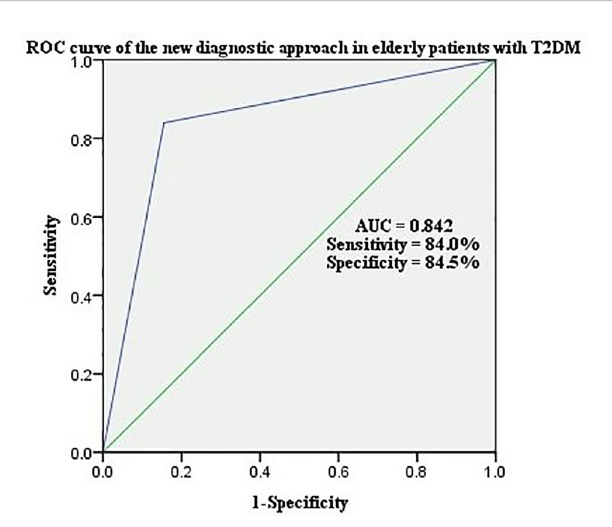
FIGURE 1 ROC curve of the a-SMI in screening patients with probable sarcopenia.